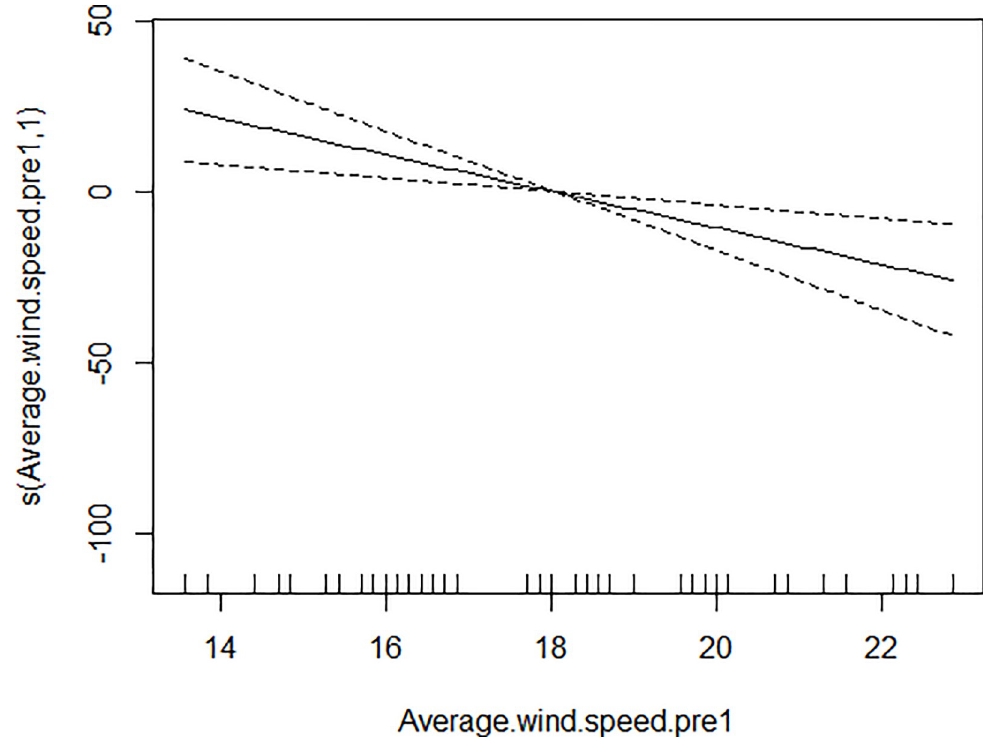
Fig 2. The relationship between BI and average wind speed pre 1